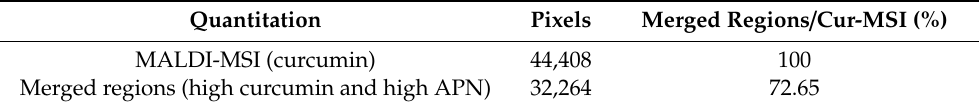
Table 1. Comparison with the highest concentration of curcumin and the highest APN expressed regions in the tumor regions. Each value represents the mean from three independent experiments.